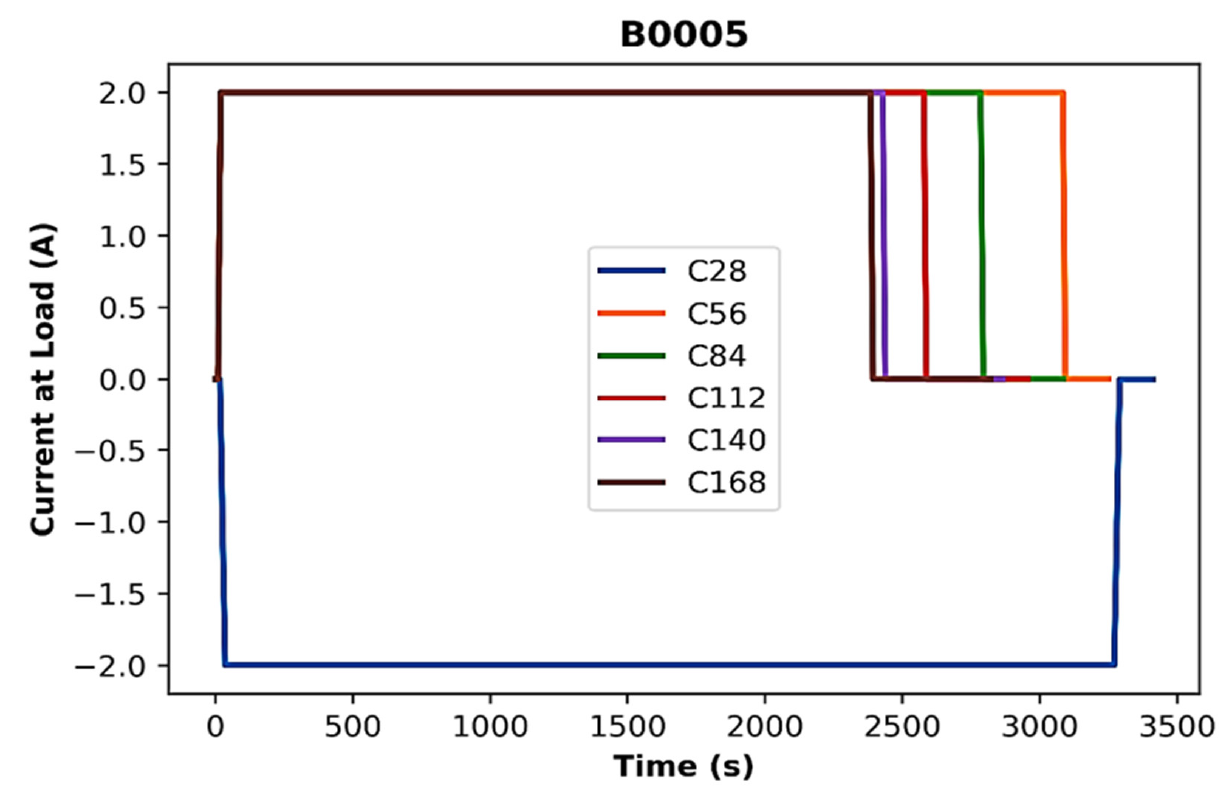
Figure 6. Discharge voltage measured at the battery B0005 at different cycles.